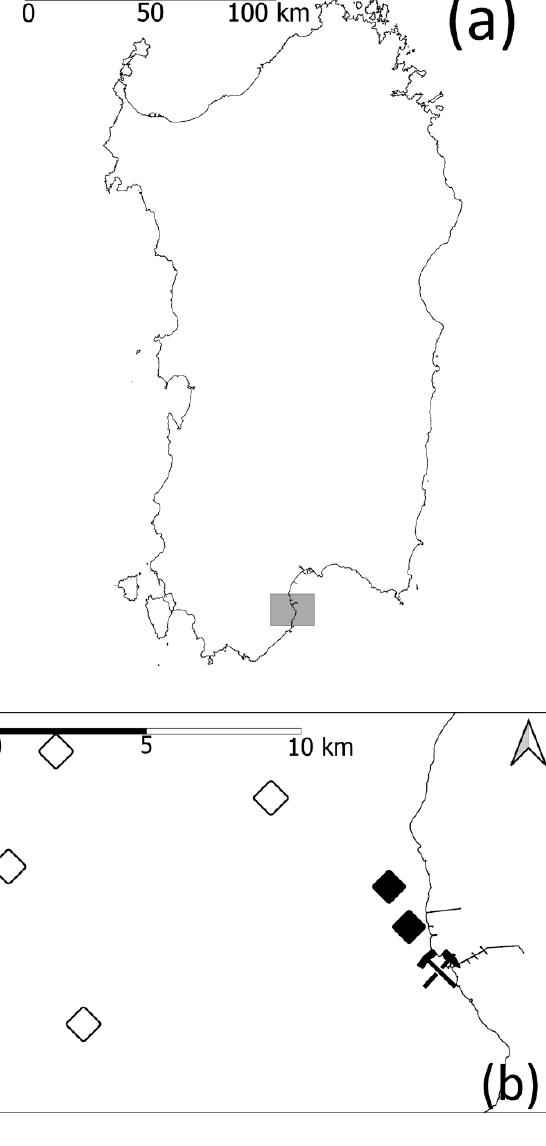
Figure 1. ( a ). The study area. ( b ). The oil refinery is represented by the crossed hammers. Black and white marks indicate exposure sites near and far from the source of contamination.